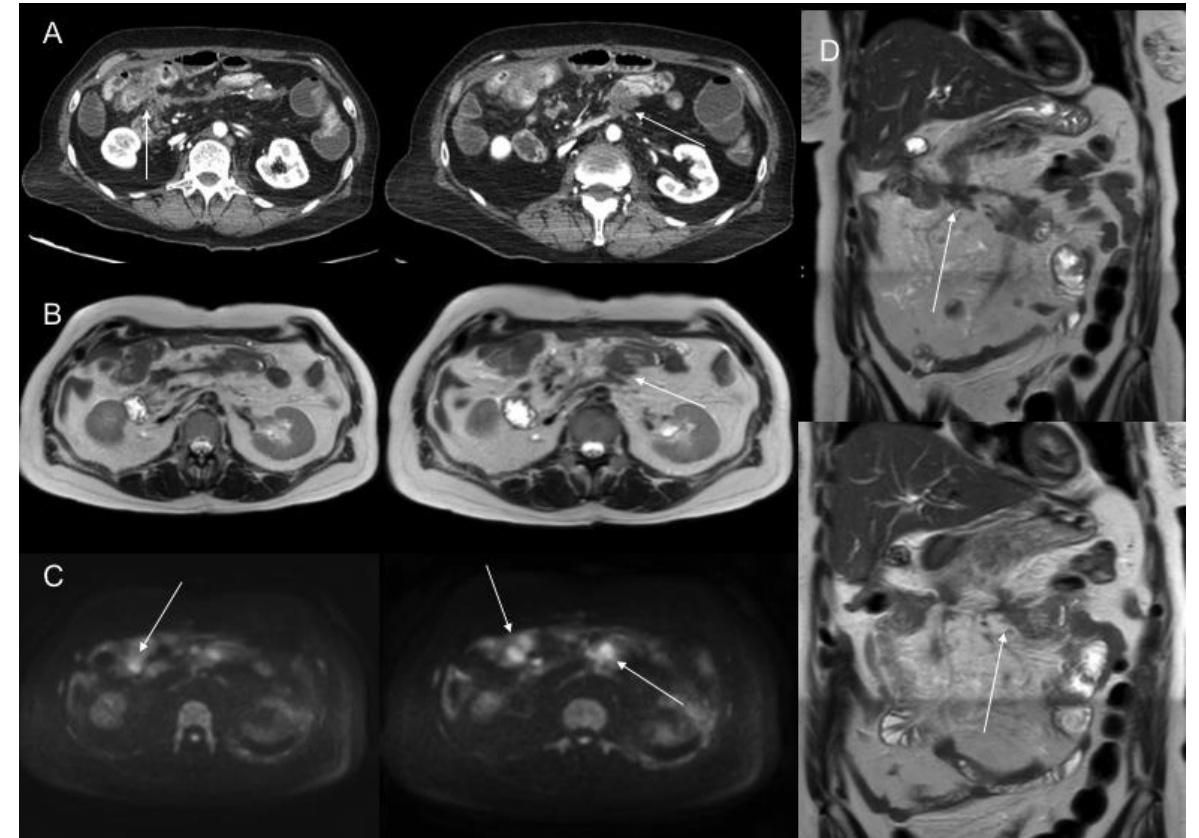
Figure 13. A 61-year-old male patient with peritoneal carcinomatosis from diffuse-type gastric cancer. Contrast-enhanced CT axial images ( A ) and T2WI axial and coronal ( B , D ) and DWI b1000 axial ( C ) MR images show mesenteric fat stranding and soft tissue nodules with multifocal infiltration and retraction of small bowel segments.